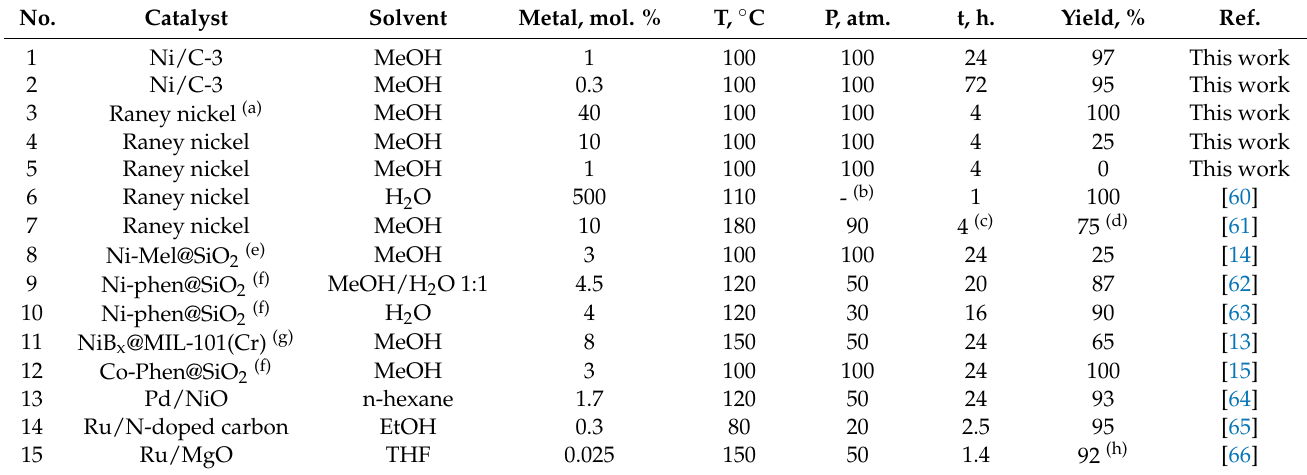
Table 5. The yields of 1,2,3,4-tetrahydroquinoline in the processes of quinoline hydrogenation by H 2 in the presence of different